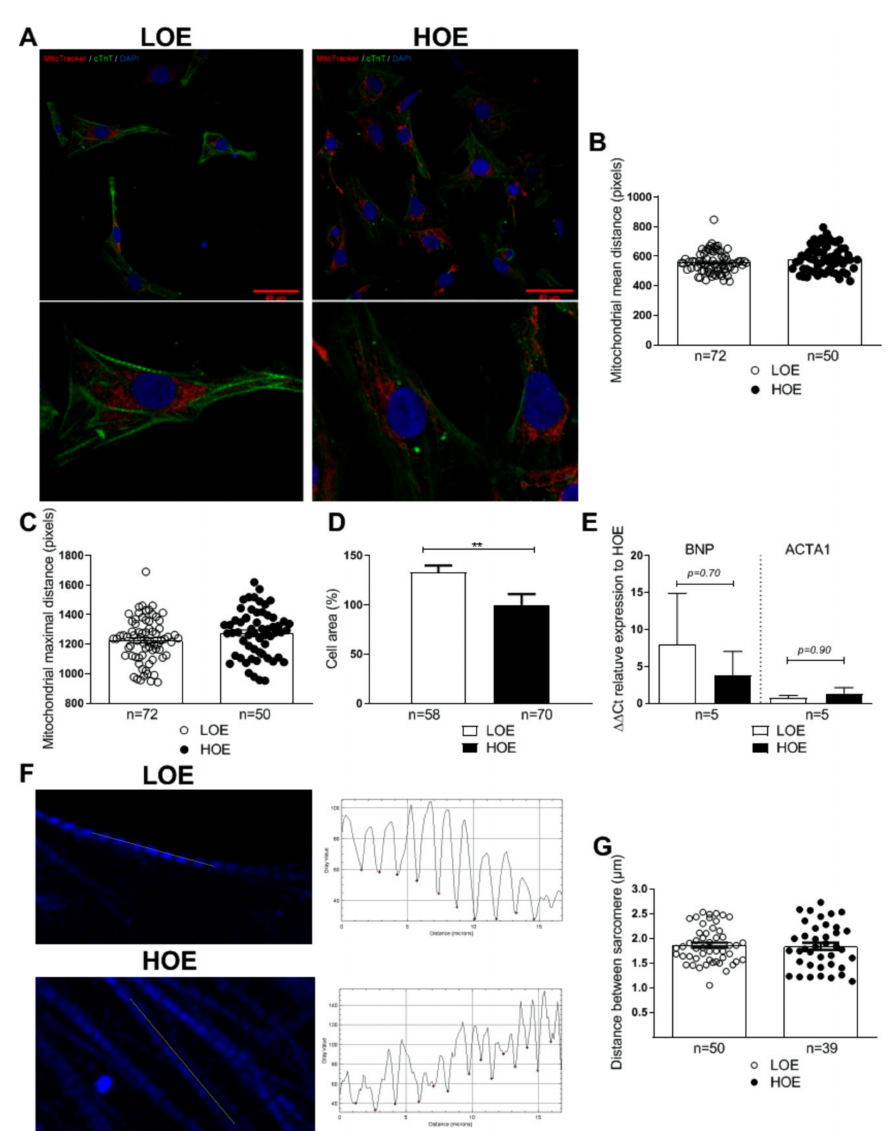
Figure 3. The mitochondrial distribution is similar in both 3D cardiac spheroids differentiated under LOE and HOE conditions. Mitochondrial localization and cell area in 25-day-old hPSC-CMs (using hiPSC UEFhfiPS1.4 and hESC CCTL12 lines) differentiated in LOE and HOE conditions were evaluated using MitoTracker dye. ( A ) Immunostaining showing the MitoTracker signal (red) and the cTnT staining (green) in 25-day-old hPSC-CMs obtained from 3D cardiac spheroids differentiated under LOE and HOE conditions. Nuclei are stained with DAPI (blue). Scale bars: 40 µ m. ( B ) Mitochondrial mean distance in 25-day-old hPSC-CMs obtained from 3D cardiac spheroids differentiated under LOE (white dot plots) and HOE (black dot plots) conditions. ( C ) Mitochondrial maximal distance in 25-day-old hPSC-CMs obtained from 3D cardiac spheroids differentiated in LOE and HOE conditions. ( D ) Cell area of 25-day-old hPSC-CMs (using hiPSC UEFhfiPS1.4 and UB47 lines) obtained from 3D cardiac spheroids differentiated in LOE and HOE conditions. ( E ) ∆∆ Ct relative gene expression analysis by qRT-PCR in 25-day-old hPSC-CMs obtained from 3D cardiac spheroids differentiated in LOE (white bars) and HOE (black bars) conditions for BNP= natriuretic peptide B and ACTA1= actin alpha skeletal muscle 1. ( F ) Measurement of the sarcomere length of hPSC-CMs (using hiPSC UEFhfiPS1.4 and hESC CCTL12 lines) in the two differentiation protocols by tracing a line of 17 µ M across the sarcomeres using an in-house developed macro on Fiji-Image J. Sarcomeric cTnT is stained in blue. Longitudinal plots were obtained through the translation of the fluorescence intensity across the line. ( G ) Distance between sarcomere in hPSC-CMs (using hiPSC UEFhfiPS1.4 and hESC CCTL12 lines) differentiated in LOE and HOE conditions. The number of cells evaluated varies from 39 to 72 for each dot plot from 3 independent biological replicates. Data are presented as mean ± SEM. Significance was calculated by Mann-Whitney test. **, p <